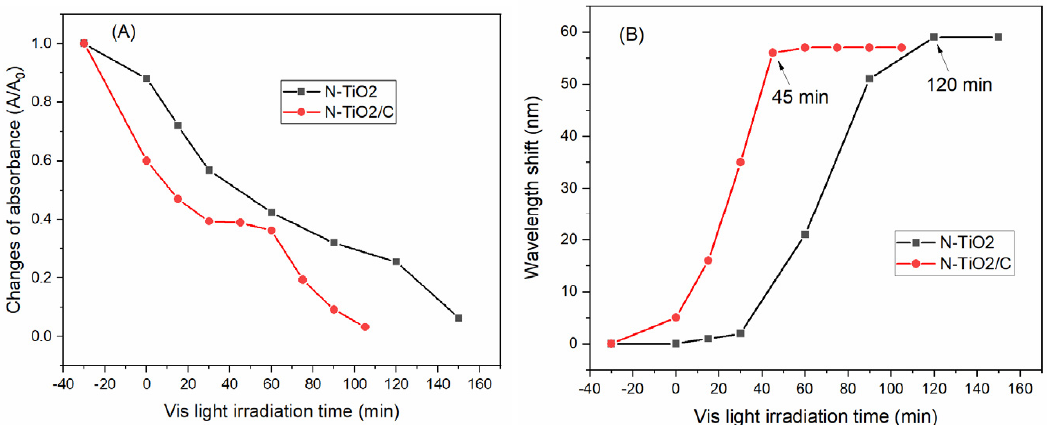
Fig. 13. (A) Absorbance changes and (B) the corresponding wavelength shifts of RhB solution maximum peak with visible‐light irradiation time during the photocatalytic processes. In the calculation of absorbance change, for simplicity it was assumed that tetraethyl‐rhodamine and its de‐ethylated derivatives have the same molar absorptivity